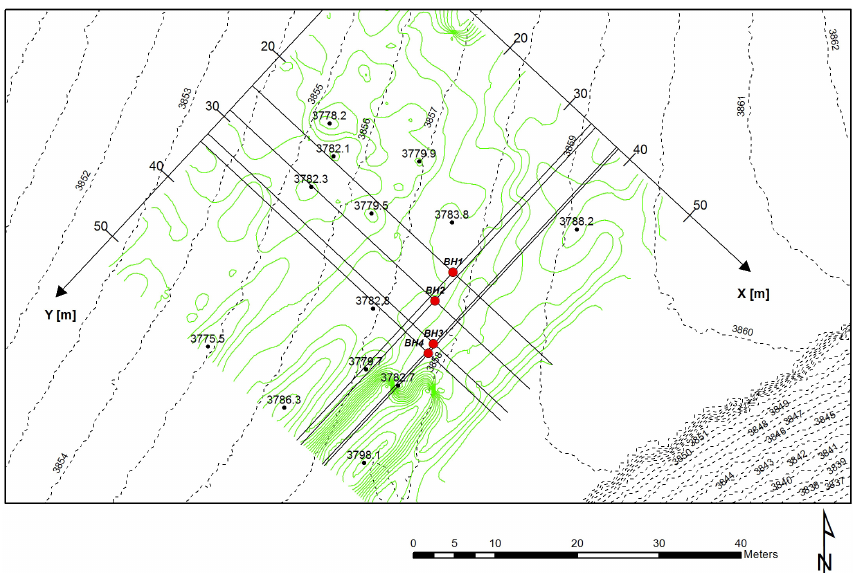
Figure 6. Bedrock contours and surface topography of the 2011 ice core drill site. Data were obtained during the 2013 GPR and lidar surveys, respectively. Bedrock contours are shown in green, while the surface topography is displayed in black. The positions where the four cores were extracted in 2011 are shown as filled red circles. The GPR X -profiles (constant y coordinate) and Y -profiles (constant x coordinate) through the locations of boreholes no. 1–4 are also shown (see also Fig. 5).